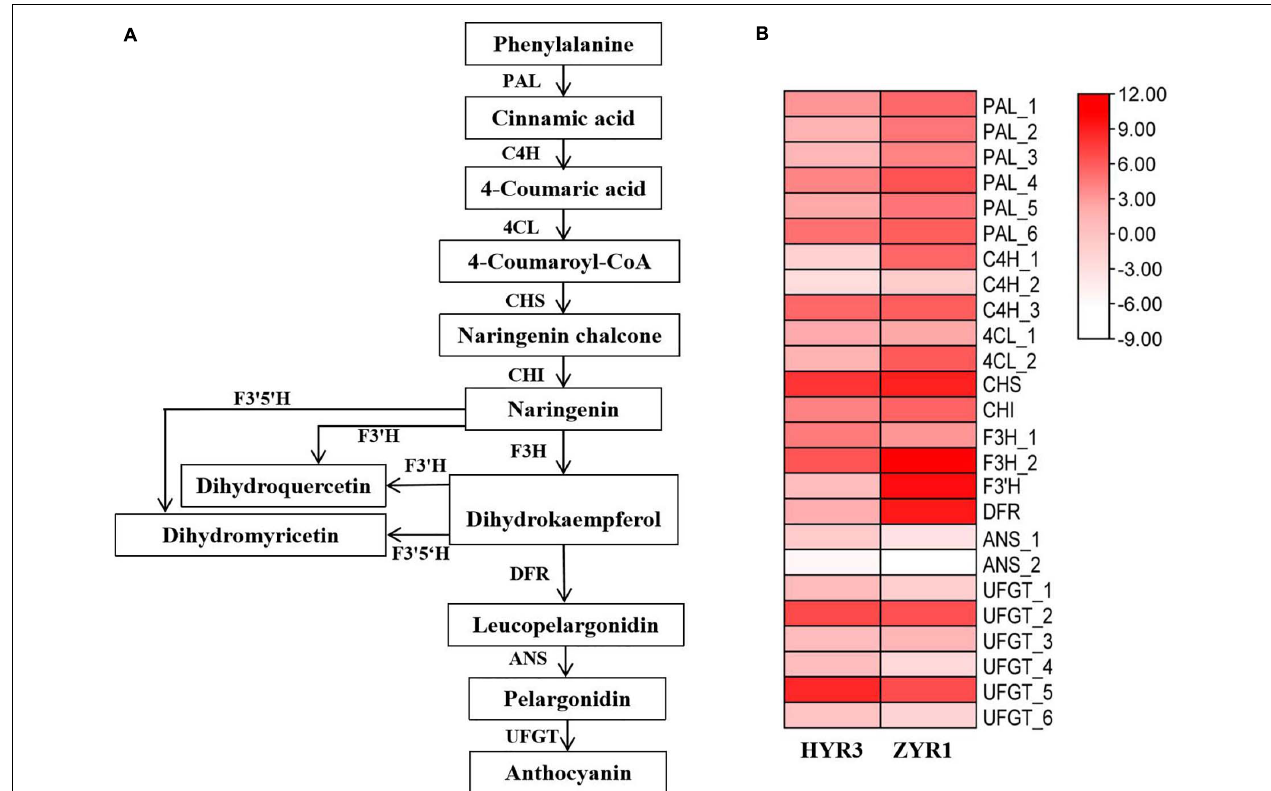
FIGURE 9 | Gene expression profiles related to the anthocyanin biosynthesis. (A) The putative anthocyanin biosynthetic pathways in plants. (B) Heatmap of genes related to anthocyanins metabolism. Scale bars show log 2 -transformed FPKM values of each gene. The intensity of colors indicates the expression levels of the